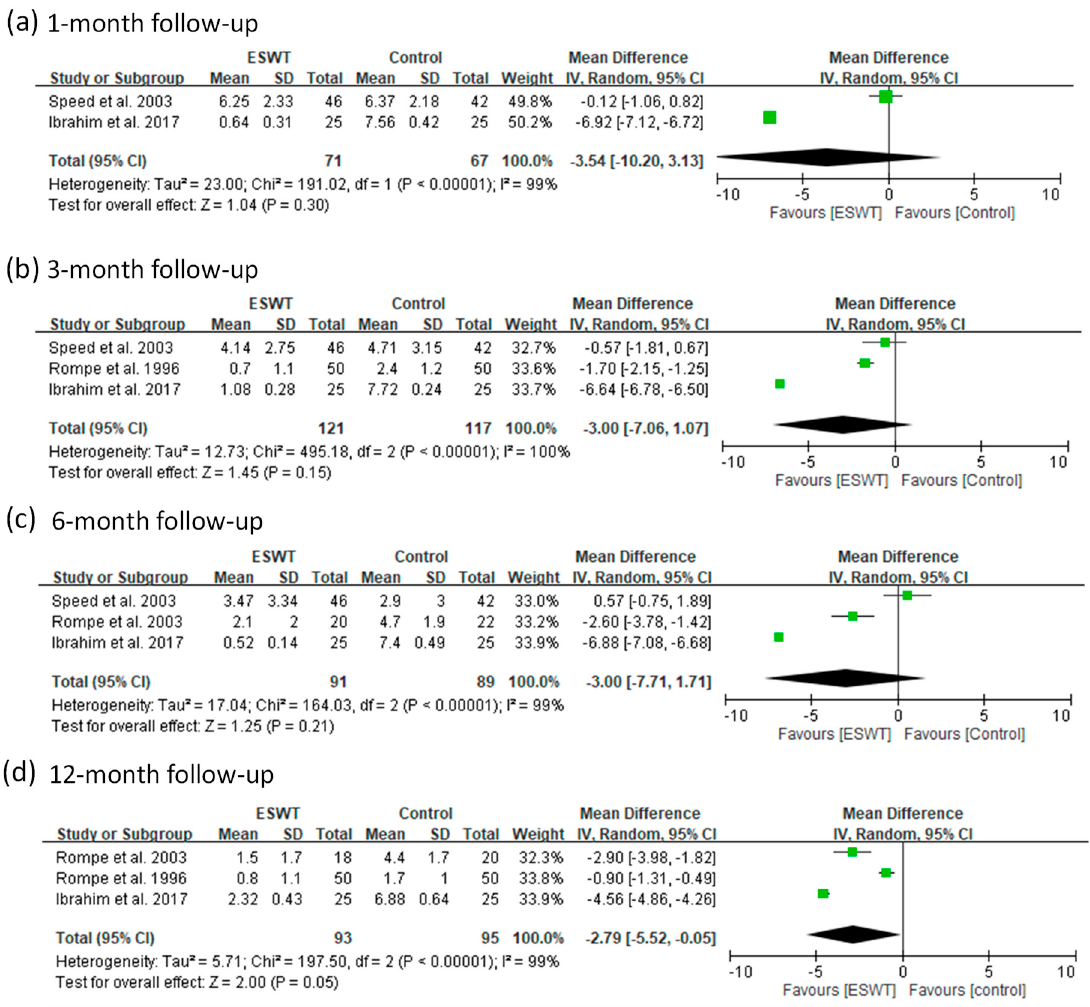
Figure 8. Forest plots of visual analog scale (VAS) scores in medium-energy ESWT and placebo-controlled groups at 1-month ( a ), 3-month ( b ), 6-month ( c ), and 12-month ( d ) follow-ups.